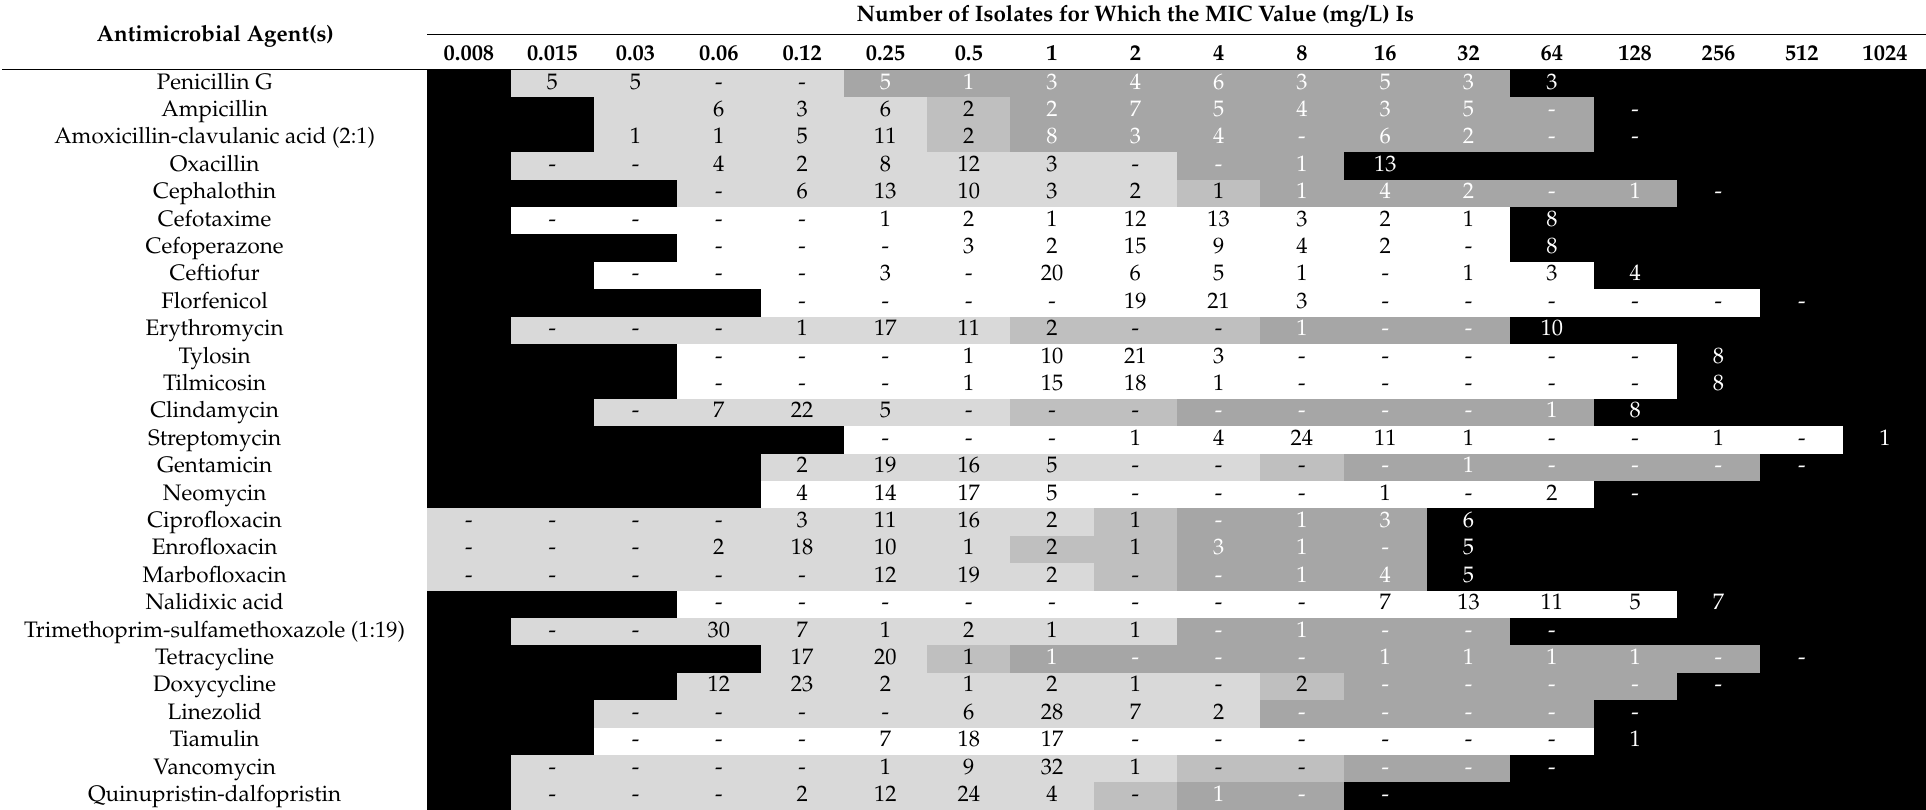
Table 1. Minimal inhibitory concentrations of the 43 feline S. aureus